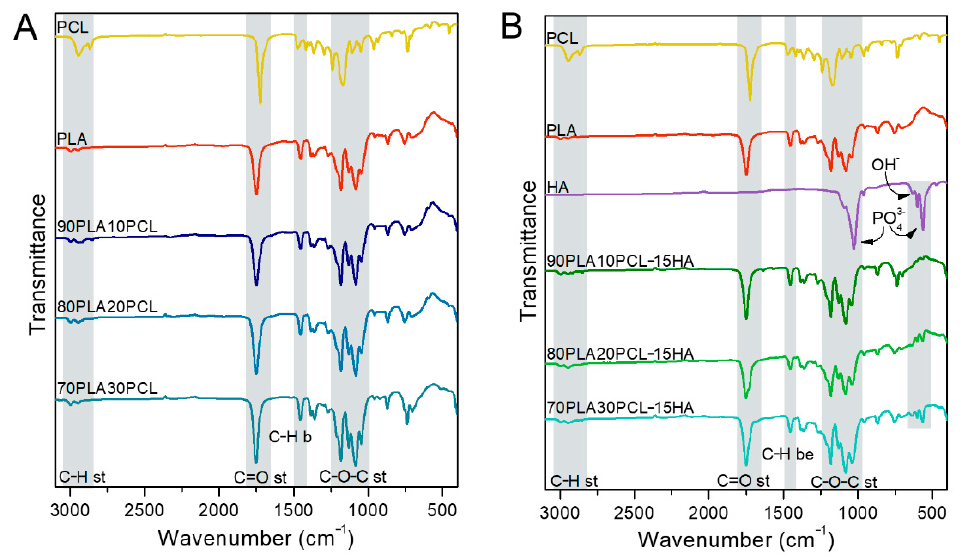
Figure 1. Fourier-Transform Infrared Spectroscopy (FTIR) spectra of pure PCL, pure PLA, pure HA and the processed polymer blends ( A ) and the composite blends ( B ).